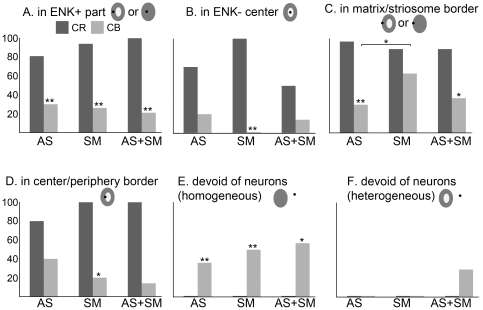
Compartmental organization of the CR- and CB-ir interneurons with respect to the ENK-ir striosomes.Bar graphs showing the percentage of sampled striosomes (Y axis) that contained CR or CB interneurons in the associative (AS), sensorimotor (SM) and associative+sensorimotor overlapped (AS+SM) territories. Each graph refers to the percentage of striosomes that contained interneurons in the mentioned locations, namely: in the dark ENK-ir striosomal aspect (A), in the light ENK-ir striosomal center (B), in the matrix/striosome border (C), in the center/periphery border (D), devoid of cells (striosomes with a homogeneous ENK+ labeling, E), devoid of cells (striosomes with visible center and periphery, F). A total of 58 (for CR; 42 homogeneous, 16 heterogeneous) and 70 (for CB; 53 homogeneous, 17 heterogeneous) striosomes were selected among all the human brains included in the study. Please note that locations A and C include both homogeneous and heterogeneous striosomes. Asterisks show significant (*, 0.05>P>0.01) or highly significant (**, P<0.01) differences between CR and CB interneurons after Fisher's exact test. The only statistical difference between territories within a neuronal group is shown in C (associative vs sensorimotor for CB interneurons).